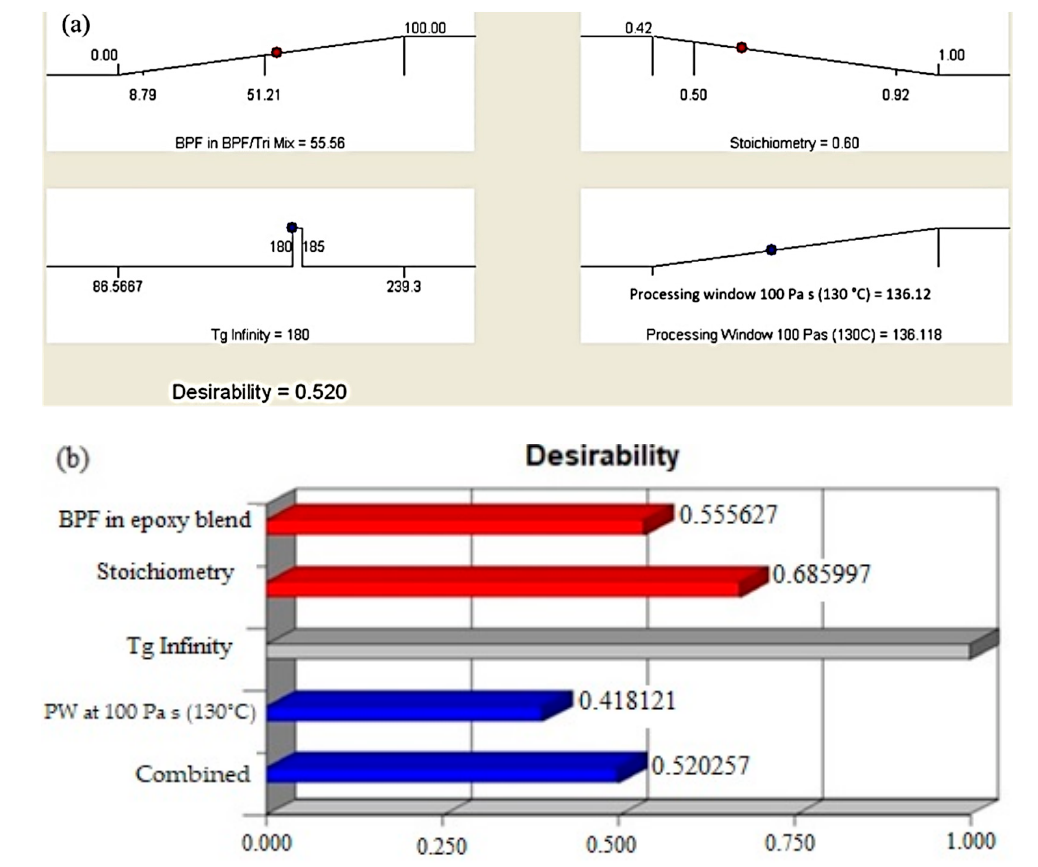
Figure 15. Desirability chart in ( a ) ramp mode of factors for optimum responses of the epoxy blend, and ( b ) histogram chart with factors and predicted responses.